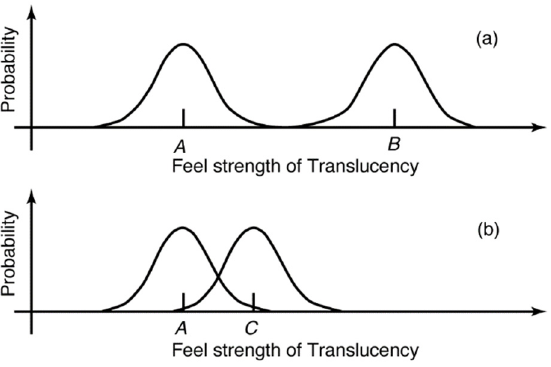
Figure 4. Dispersion of feel strength of visual perception and its overlap effect in pairwise comparison: ( a ) the distributions do not overlap and ( b ) the distributions overlap.